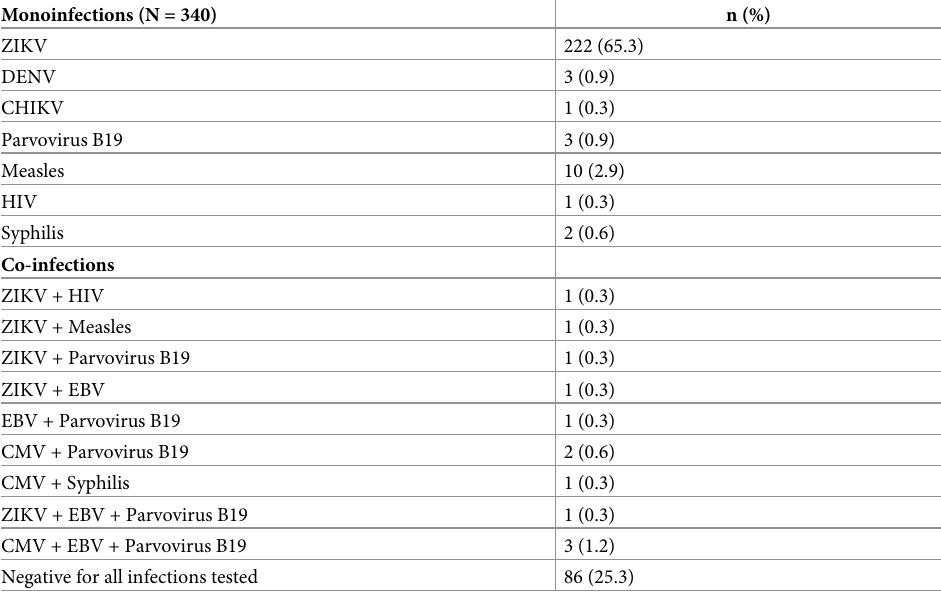
Table 3. Prevalence of arboviruses and other infectious causes of rash and co-infections in patients treated at FMT-HVD, Manaus, between February 2018 to May 2019. Monoinfections (N =